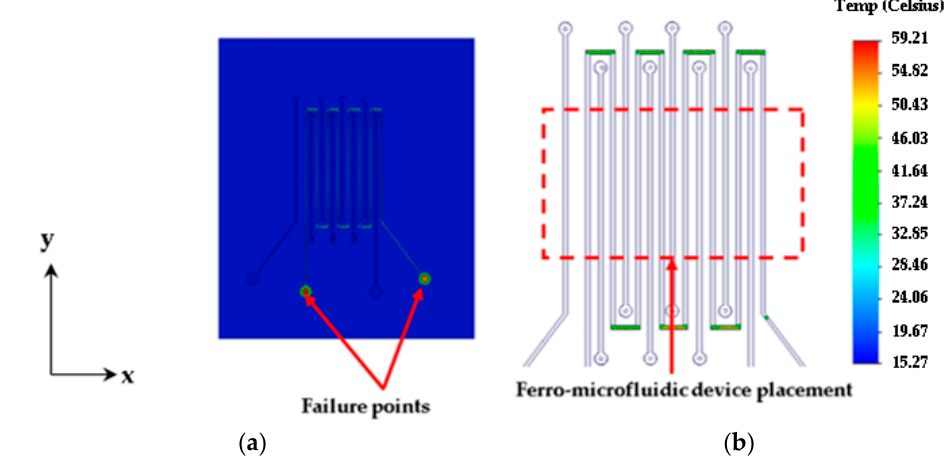
Figure 7. Thermal simulations at 2 W for 3 s: ( a ) thermal contours and ( b ) thermal iso-contours. The dashed lines in the iso-contour represent the area where the ferro-microfluidic device will sit. The black arrow on the color scale represents the temperature threshold for cell damage.